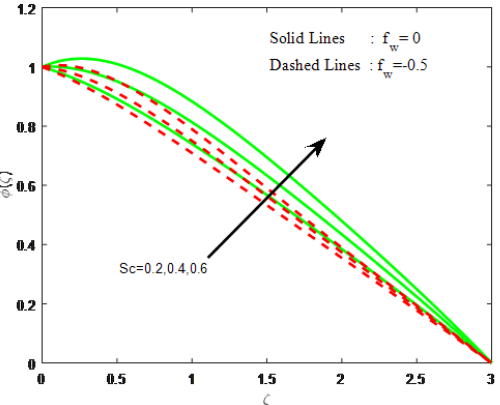
Fig. 18: The effect of Schmidt number ( Sc ) on concentration field